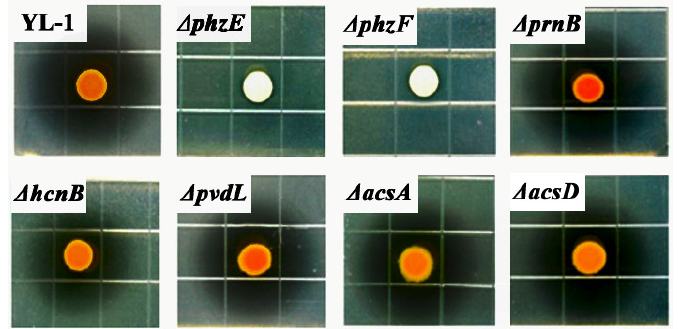
Figure 1. Antibacterial activity of P. chlororaphis YL-1 and its seven mutants on LB plates. All strains precultured in liquid LB medium at 28 °C and 200 rpm for 24 h were resuspended in distilled liquid LB medium to the desired cell density of 10 8 CFU/mL. After spraying the suspension of A. citrulli (10 8 CFU/mL) onto the surface of LB plates for 1 s, 5 μL cells of strain YL-1 or mutants were injected into the central hole (5 mm) of LB plates and incubated at 28 °C for 48 h. Distilled LB medium was used as a control. The inhibitory zone diameters of strain YL-1 and mutants were measured when